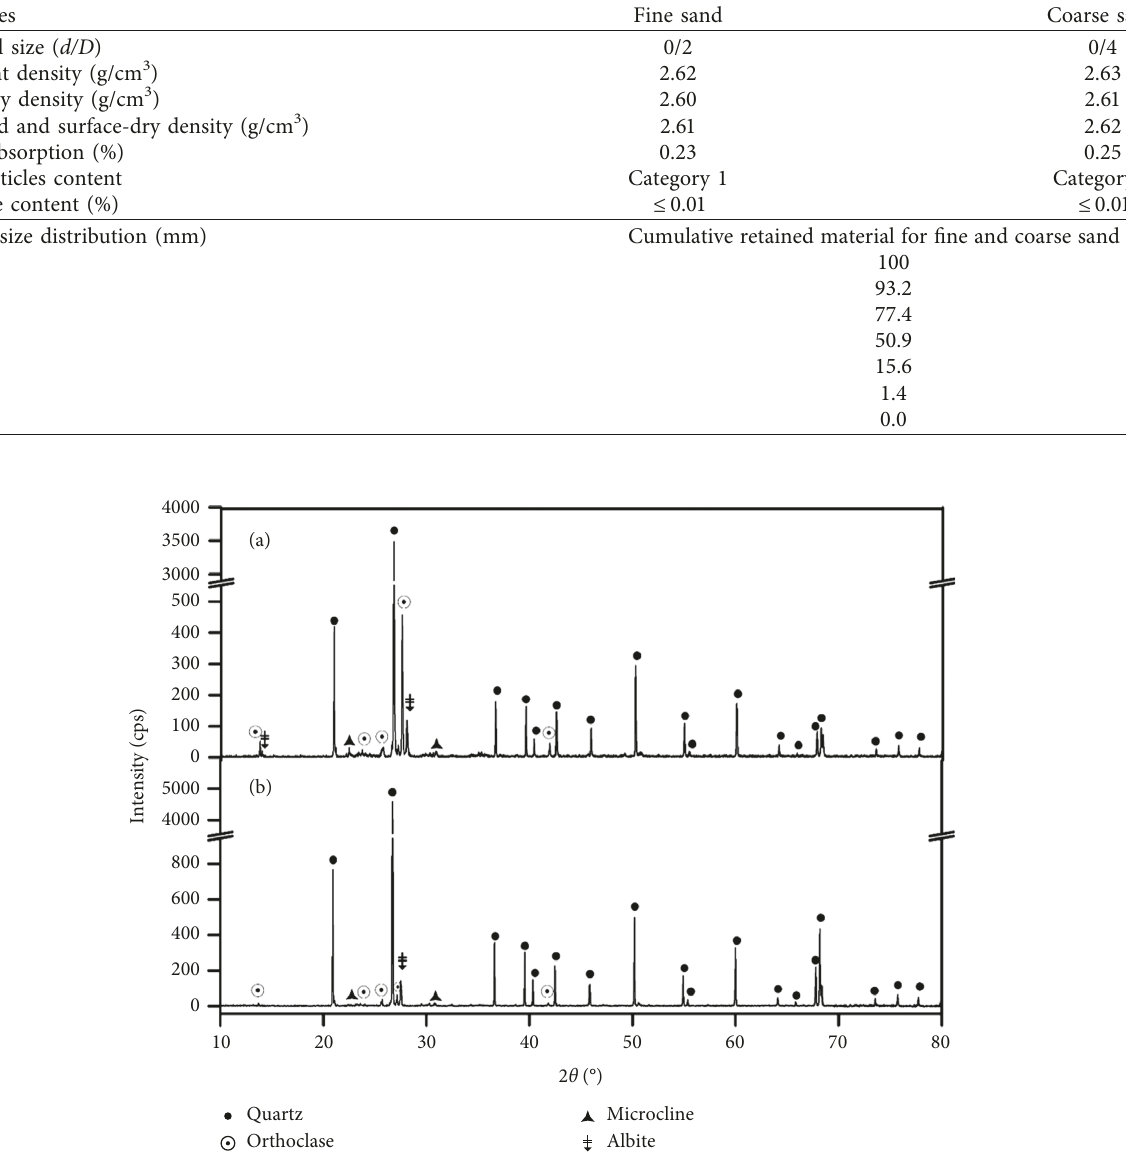
Table 2: Characteristics of fine and coarse sand.